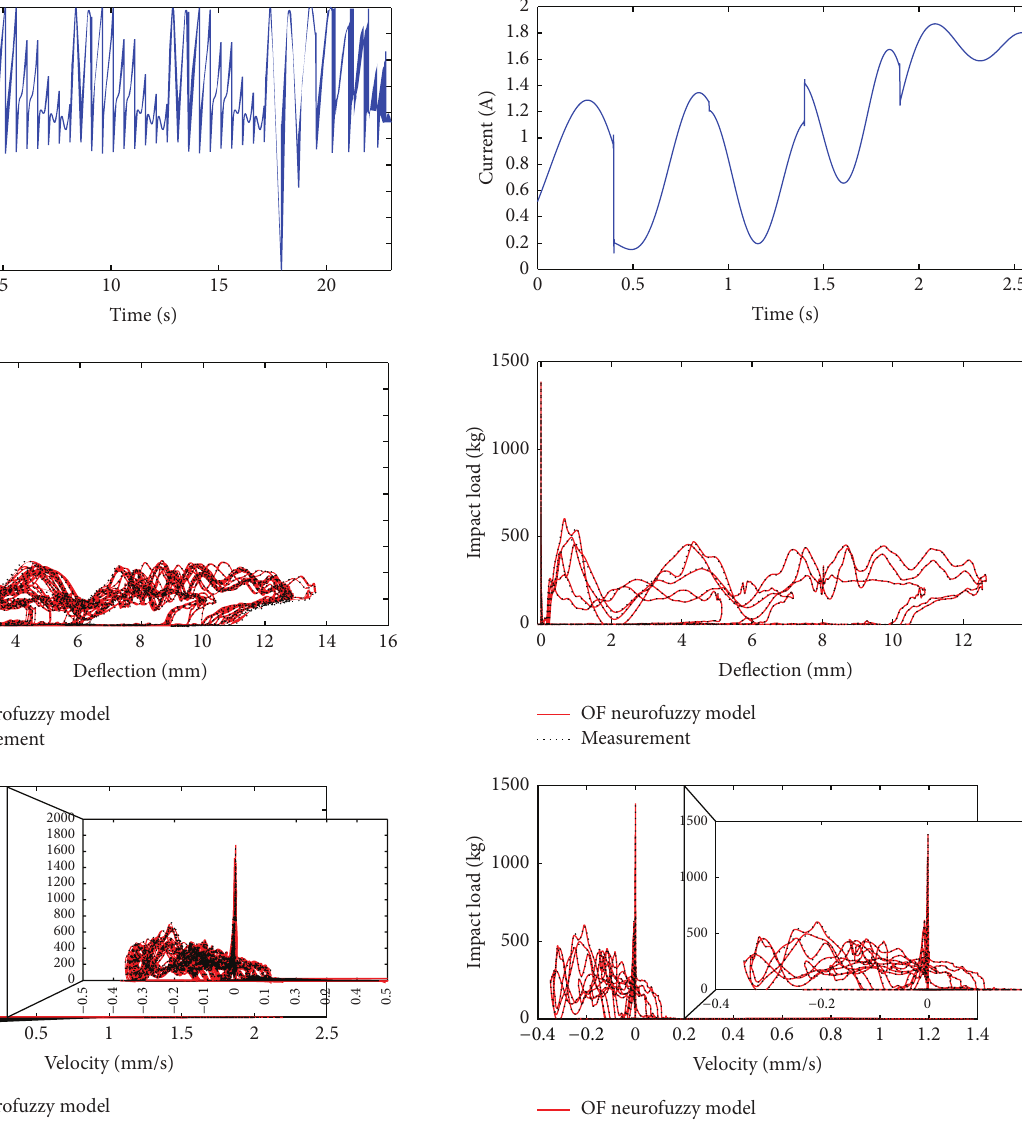
Figure 22: Impact load-displacement and impact load-velocity curves: different drop release heights and sinusoidal current signal.